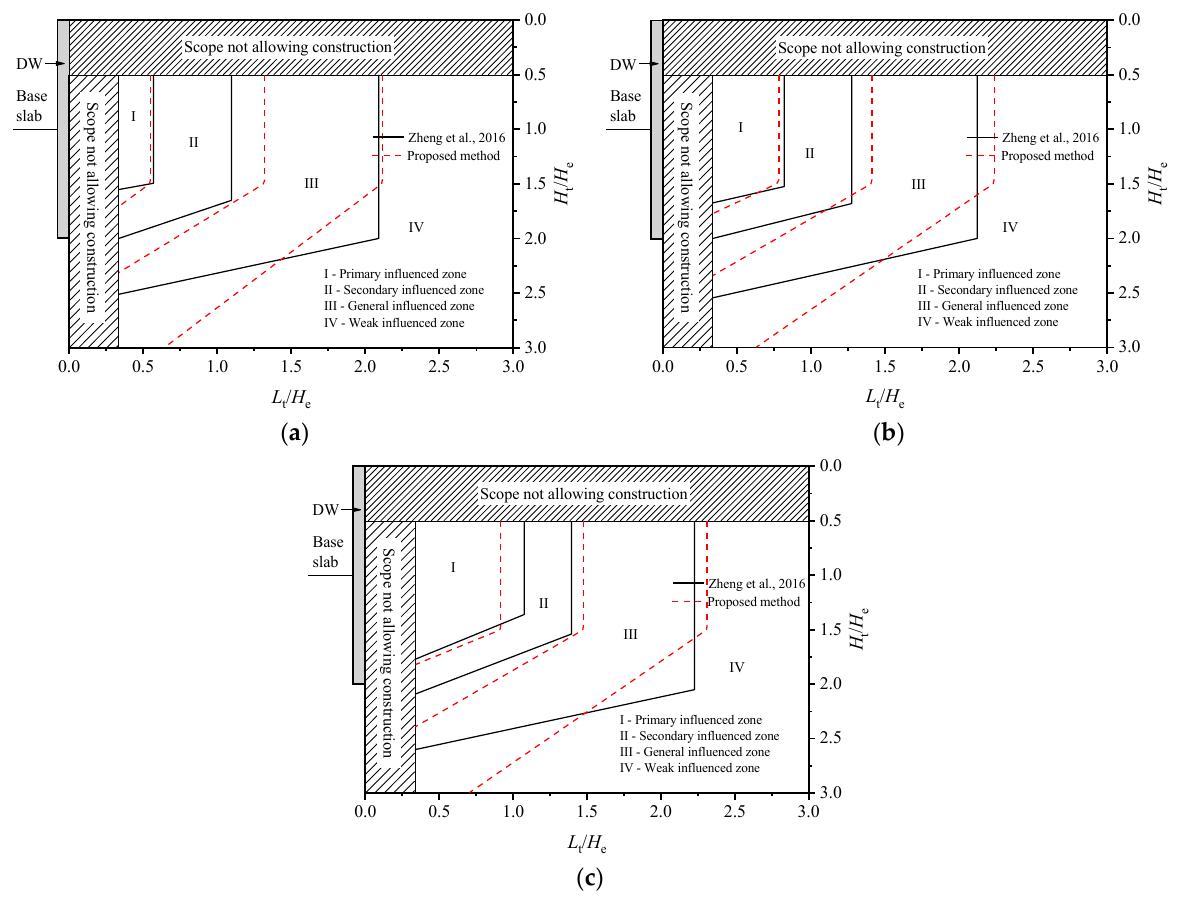
Figure 13. Comparison of the predicted in fl uenced zone with the results in current research: ( a ) H e